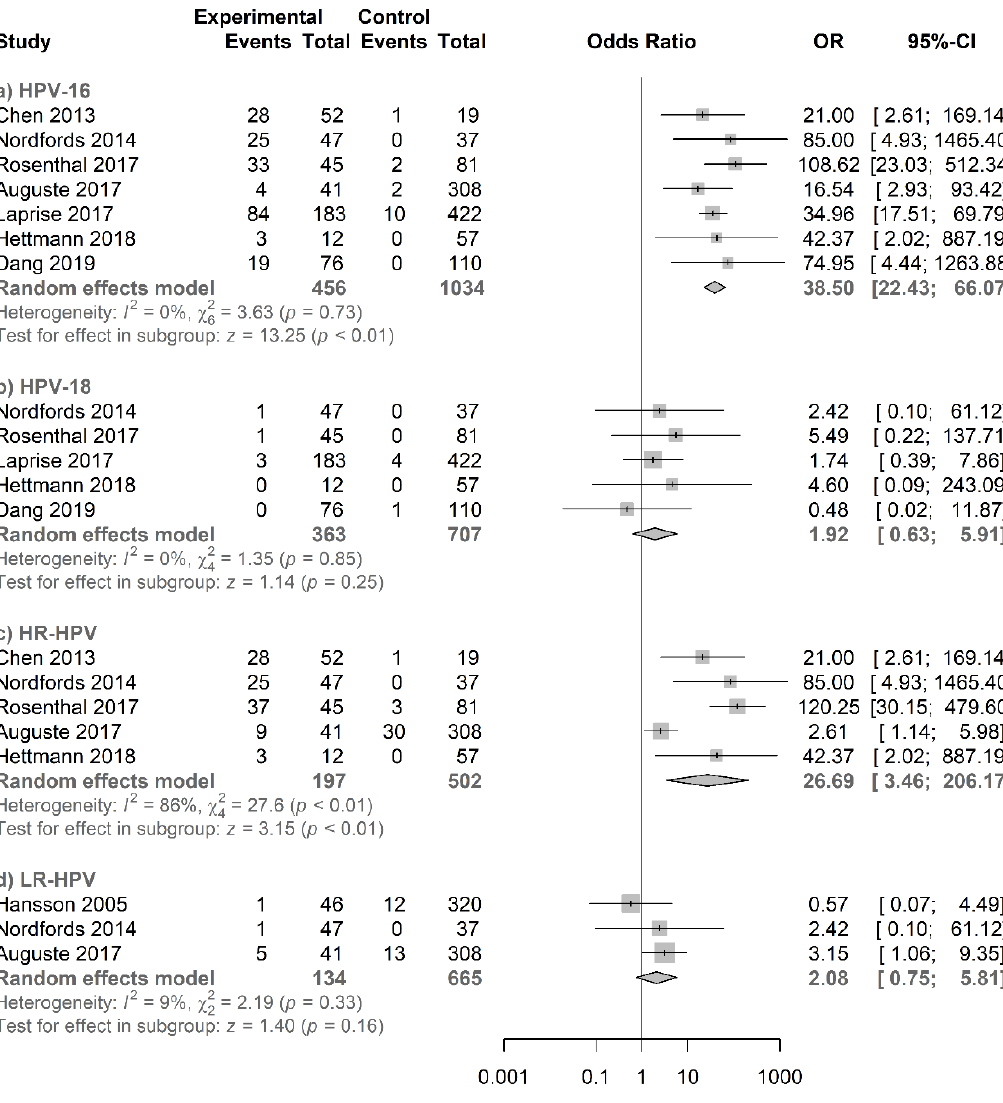
Figure 7. Forest plot for the studies on the association between salivary HPV and oropharyngeal cancer. The squares indicate the ORs in each study, with square sizes inversely proportional to the standard error of the OR. The diamond shape indicates the pooled ORs. Horizontal lines represent 95% CIs. I2 > 50% indicates severe heterogeneity. ( a ) HPV16, ( b ) HPV18, ( c ) HR-HPV, and ( d ) LR- HPV.